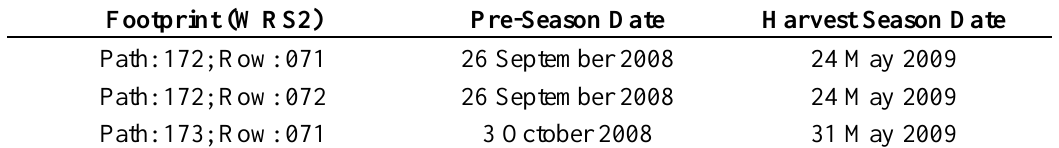
Table A1. TM scene acquisition dates for each of three footprints